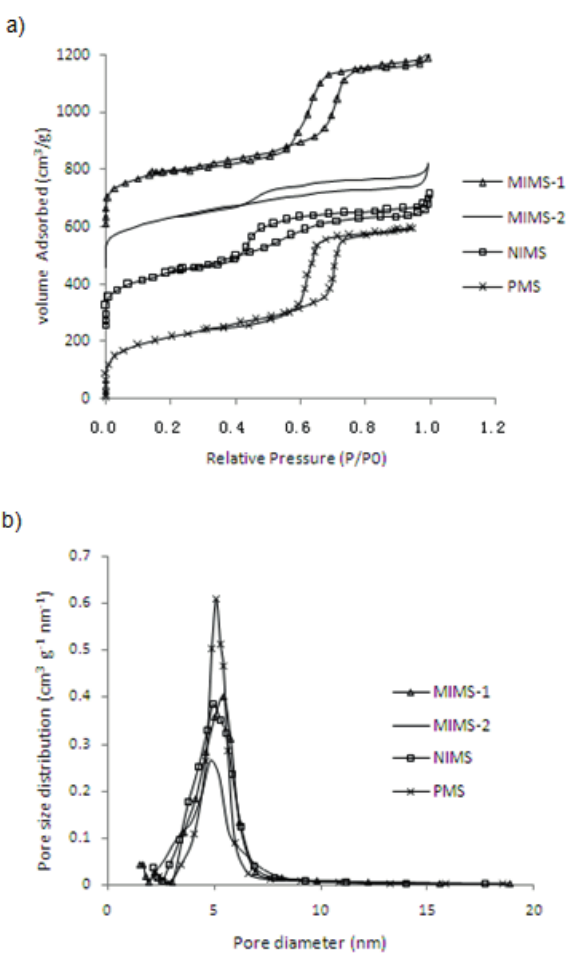
Figure 2: a) Nitrogen adsorption/desorption isotherms and b) BJH pore size distributions of MIMS- 1 , MIMIS- 2 , NIMS and PMS.